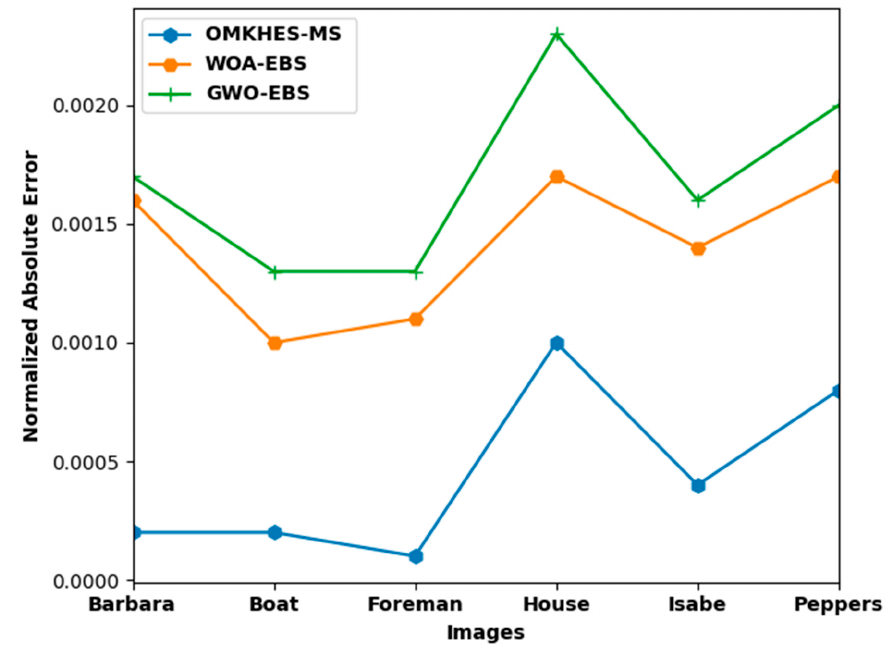
Figure 13. Comparative NAE analysis of OMKHES-MS technique with existing models.